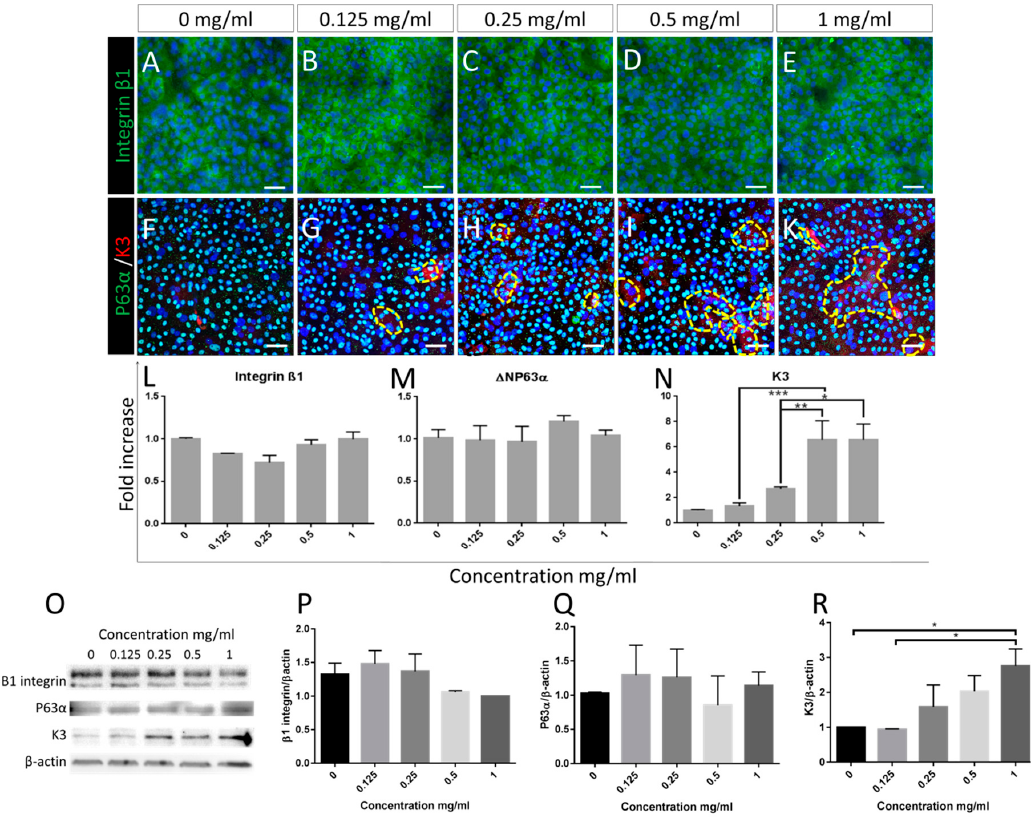
Figure 3. Putative limbal epithelial stem cell marker expression is not affected by Bevacizumab, except Keratin 3 levels which increase following treatment. Immunofluorescence staining of the basal marker integrin β 1 ( A–E alexa488) and of p63 α ( F– K alexa488) as well as RNA and protein expression (densitometry analysis of Western blotting) of integrin β 1 and ΔΝΡ 63 α ( L , M and P , Q respectively) remained unchanged following treatment with Bevacizumab. In contrast, the mature corneal epithelial marker keratin 3, localised in cells with flattened and enlarged morphology ( F–K , alexa555, positive areas surrounded by yellow dotted lines) exhibited a significant and dose responsive increase following treatment with Bevacizumab as shown by both QPCR assessment ( N ) and Western blotting densitometry analysis ( R ). Representative blots are depicted in panel O . For immunofluorescence: number of replicates n ≥ 3. Scale bars correspond to 50 μ m. For RT ‐ PCR and Western blotting, number of replicates n = 3 and * p < 0.05, ** p < 0.01, *** p < 0.001. In densitometry analysis ( P–R ), control group set as 1.